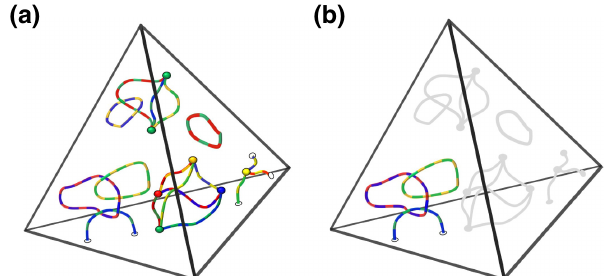
FIG. 26. Schematic representation of the Z -gauge flux γ in the bulk (enclosed by the black tetrahedron) of the 3D subsystem color code on the lattice L 3D in Fig. 5(b). (a) The flux γ consists of strings of six different colors. There are seven branching points of γ (depicted as red, green, blue, and yellow vertices). The flux